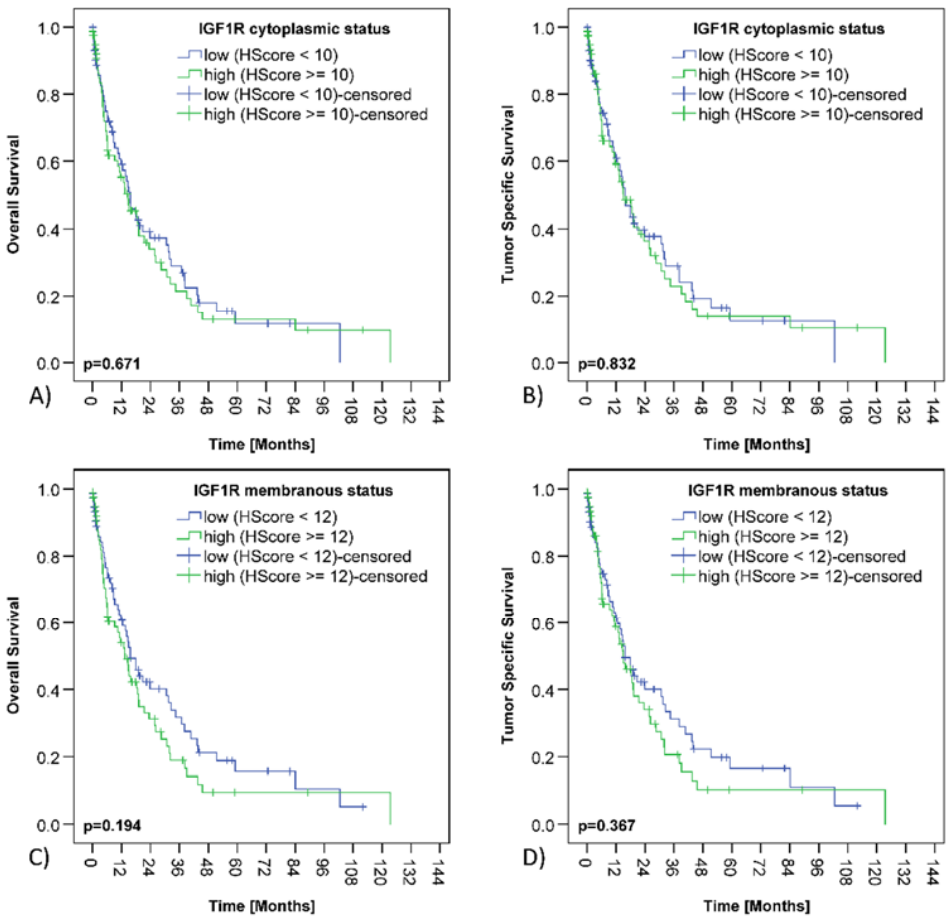
Figure 4. IGF1 receptor expression and survival of PDAC patients. Kaplan–Meier curves displaying correlations between cytoplasmic IGF1 receptor expression in cancer cells (c-IGF1R) and overall ( A ) ( p = 0.671) and tumor specific survival ( B ) ( p = 0.832). Kaplan–Meier curves presenting correlations between membranous IGF1 receptor expression in cancer cells (m-IGF1R) and overall ( C ) ( p = 0.194) and tumor specific ( D ) ( p = 0.367)